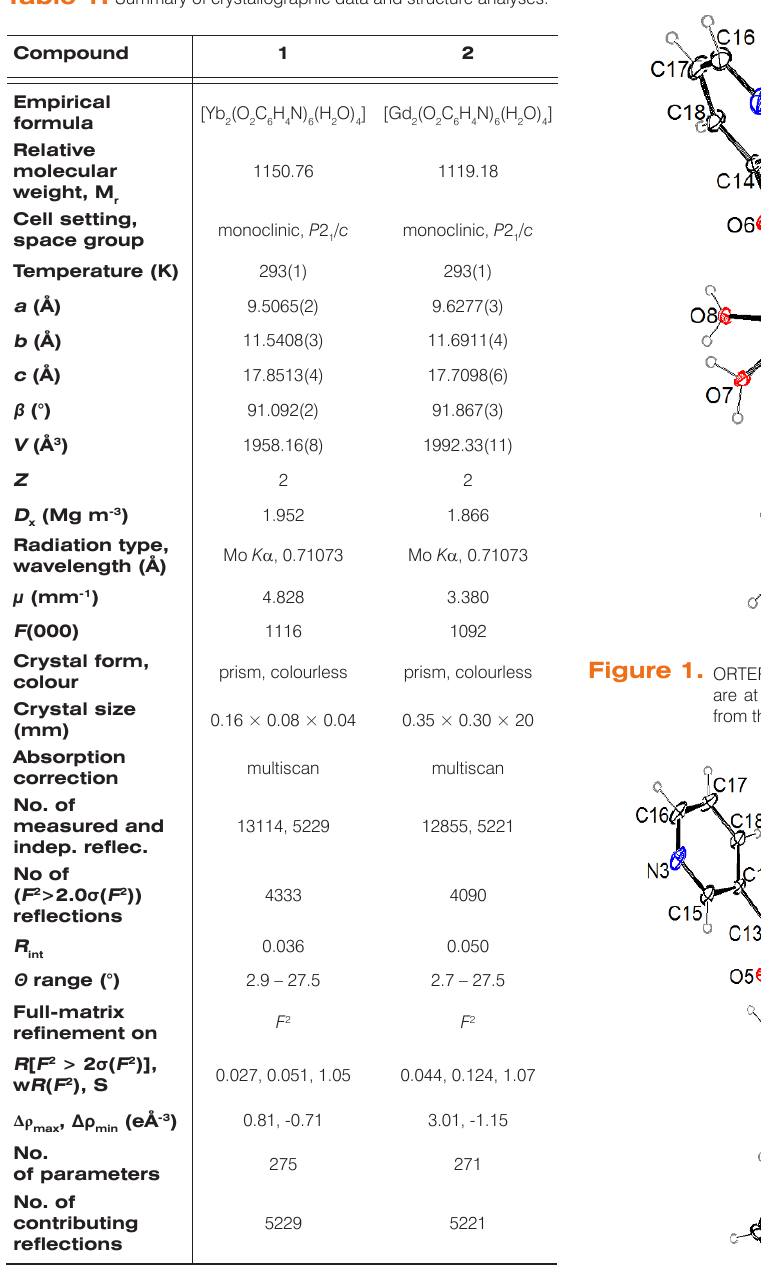
Table 1. Summary of crystallographic data and structure analyses.